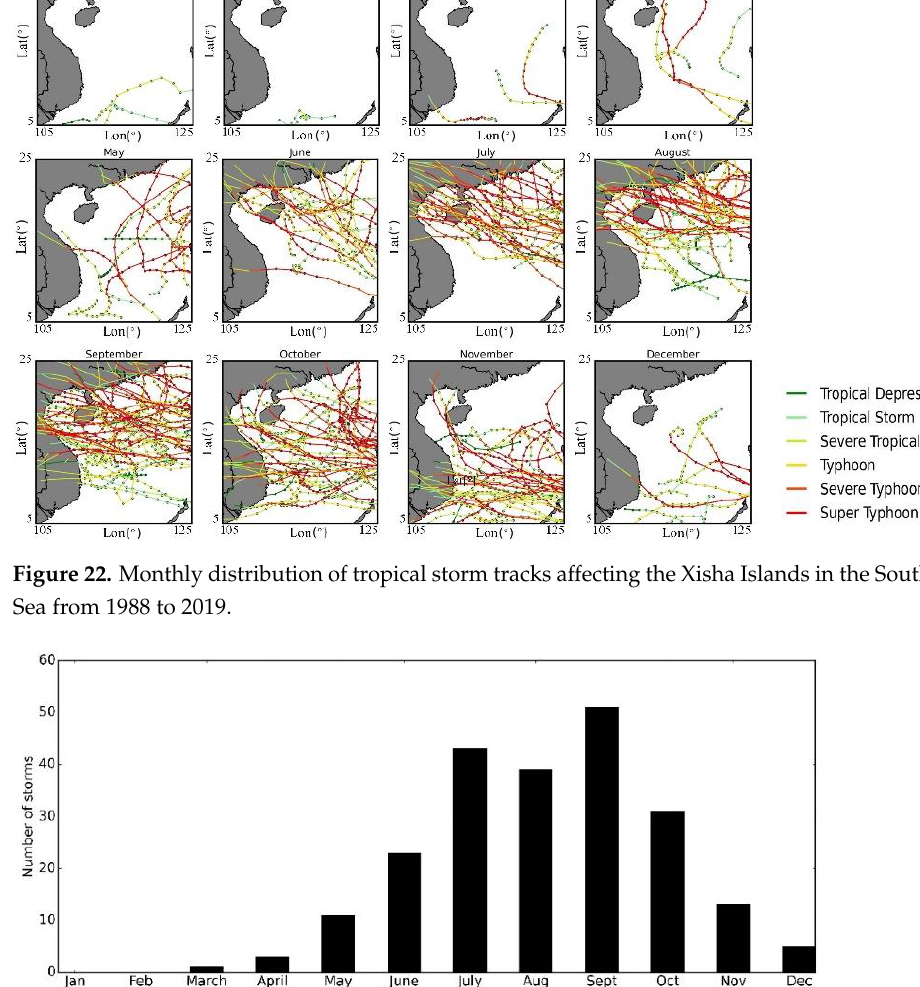
Figure 23. Monthly distribution of tropical storm frequency affecting the Xisha Islands.